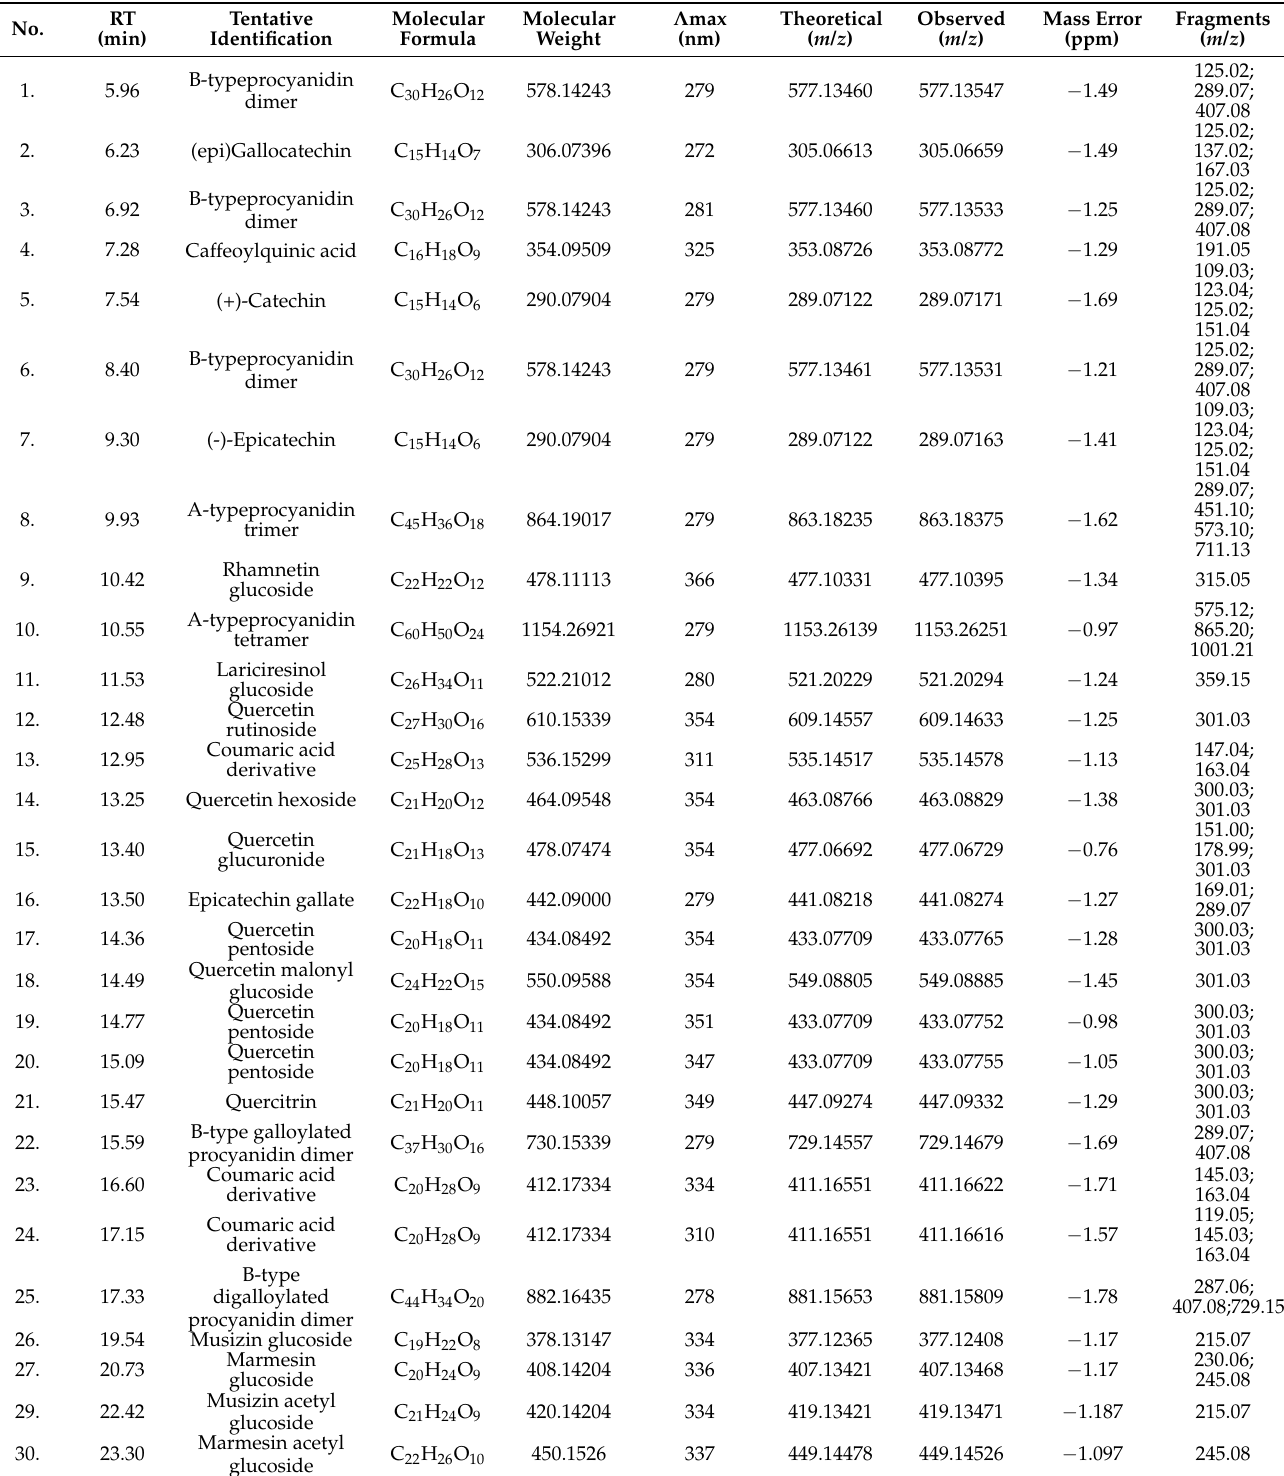
Table 1. Phytochemicals tentatively identified by LC-Q-Orbitrap-HRMS in R. nigrum